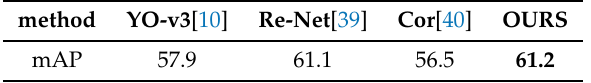
Table 7. Comparisons with the state-of-the-art methods on MS COCO. The YO-v3 indicates the YOLOv3 method. The Re-Net indicates the RetinaNet method and the Cor means the CornerNet method.